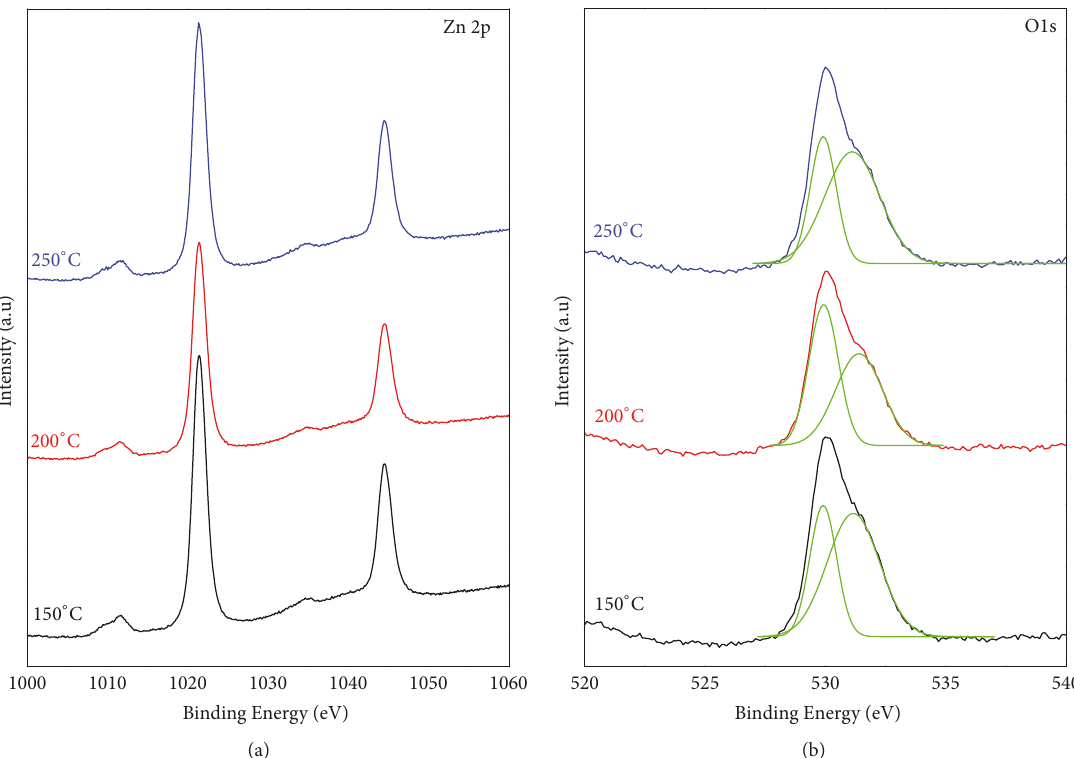
Figure 6: XPS spectra of Zn 2p (a) and O1s (b) peaks for 200 nm thick ZnO thin films deposited at 18keV and distance of 6cm at denoted substrate temperatures.